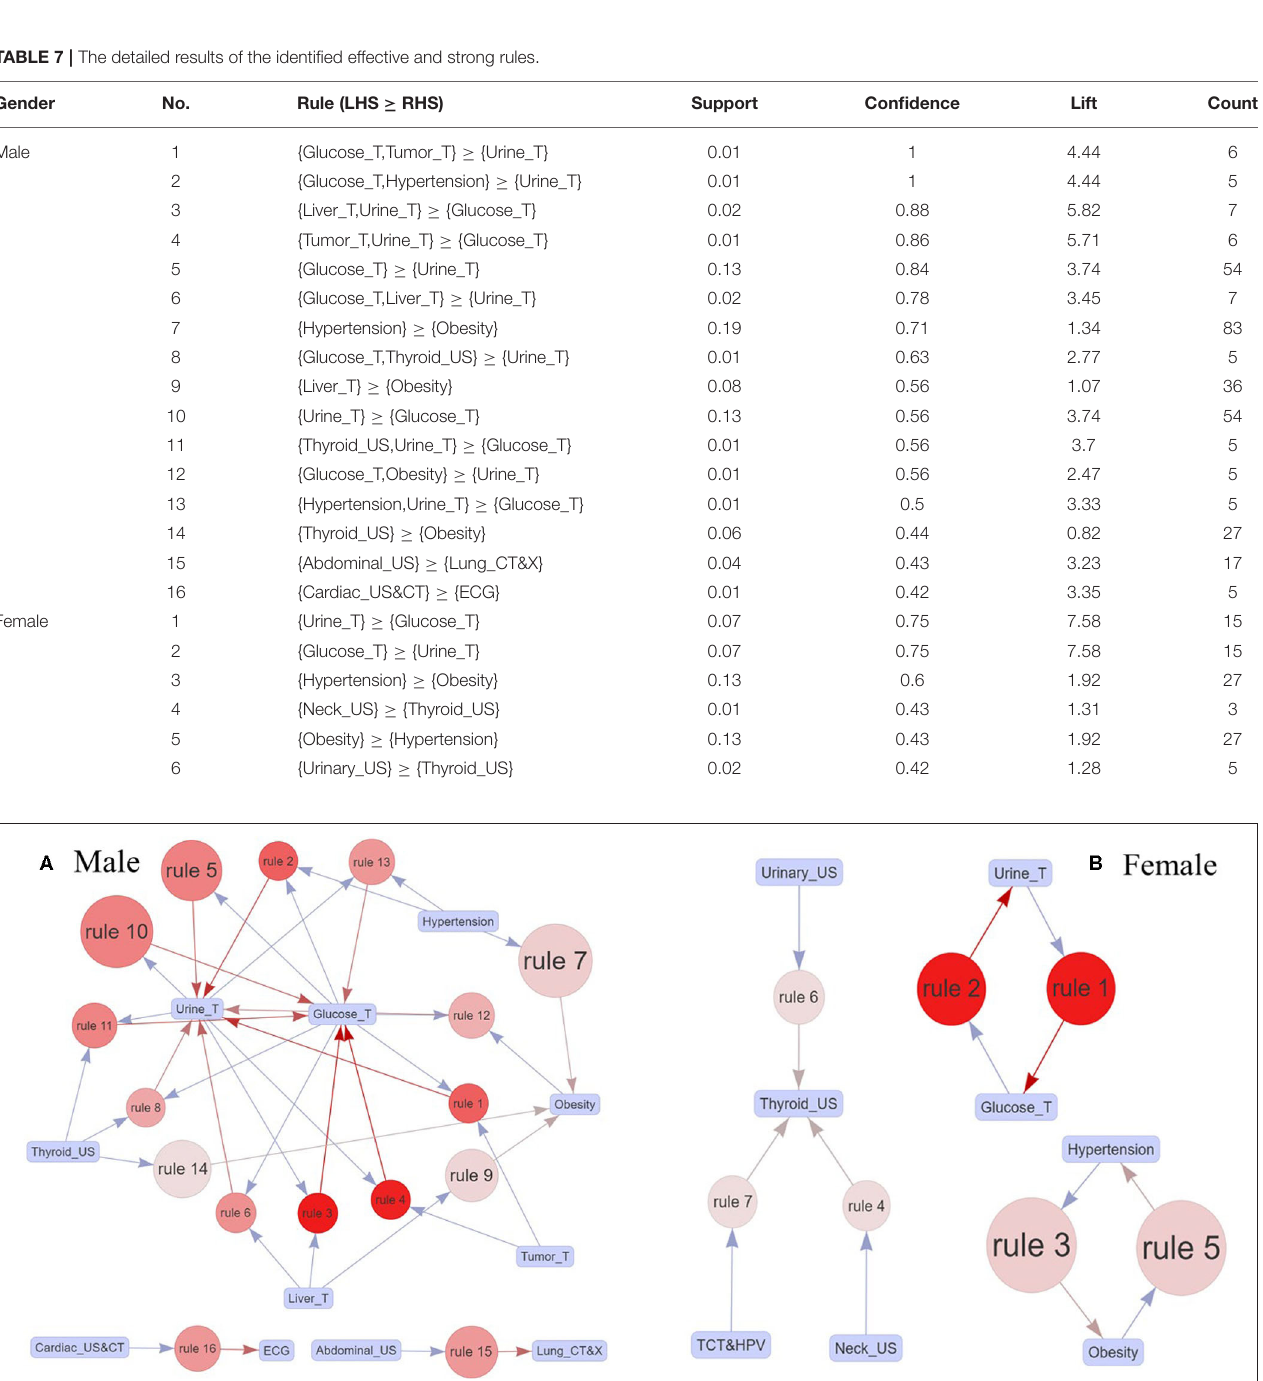
confidence of the former is larger than that of the latter. Also, the confidence values of the first two rules ({glucose_T, tumor_T} ≥ {urine_T}, {glucose_T, hypertension} ≥ {urine_T}) were 1, showing the critical values on the RHS appeared certainly along with the critical values on the LHS. While for